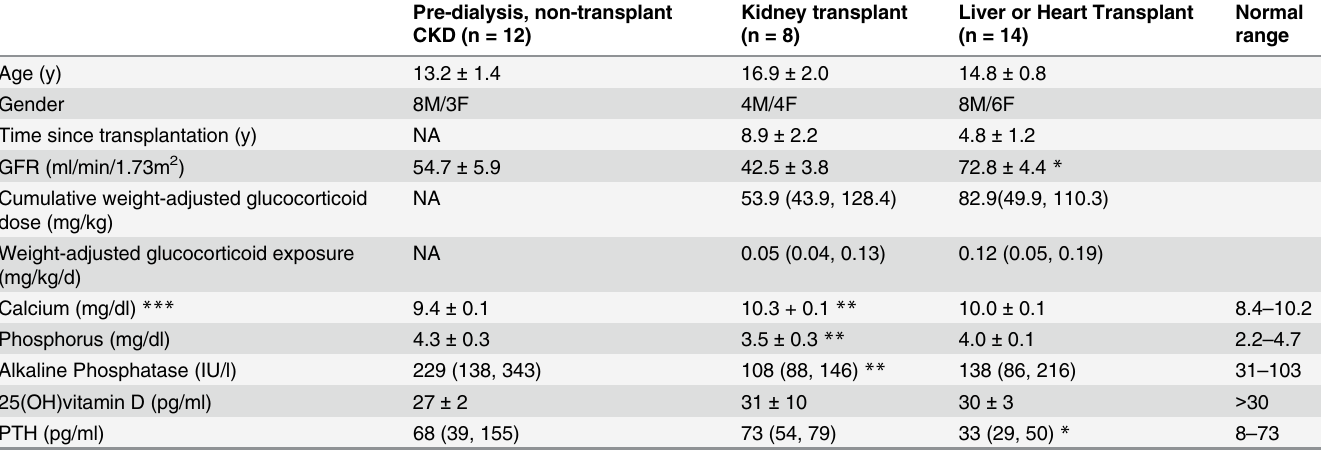
Table 1. Demographic and biochemical parameters in transplant and CKD